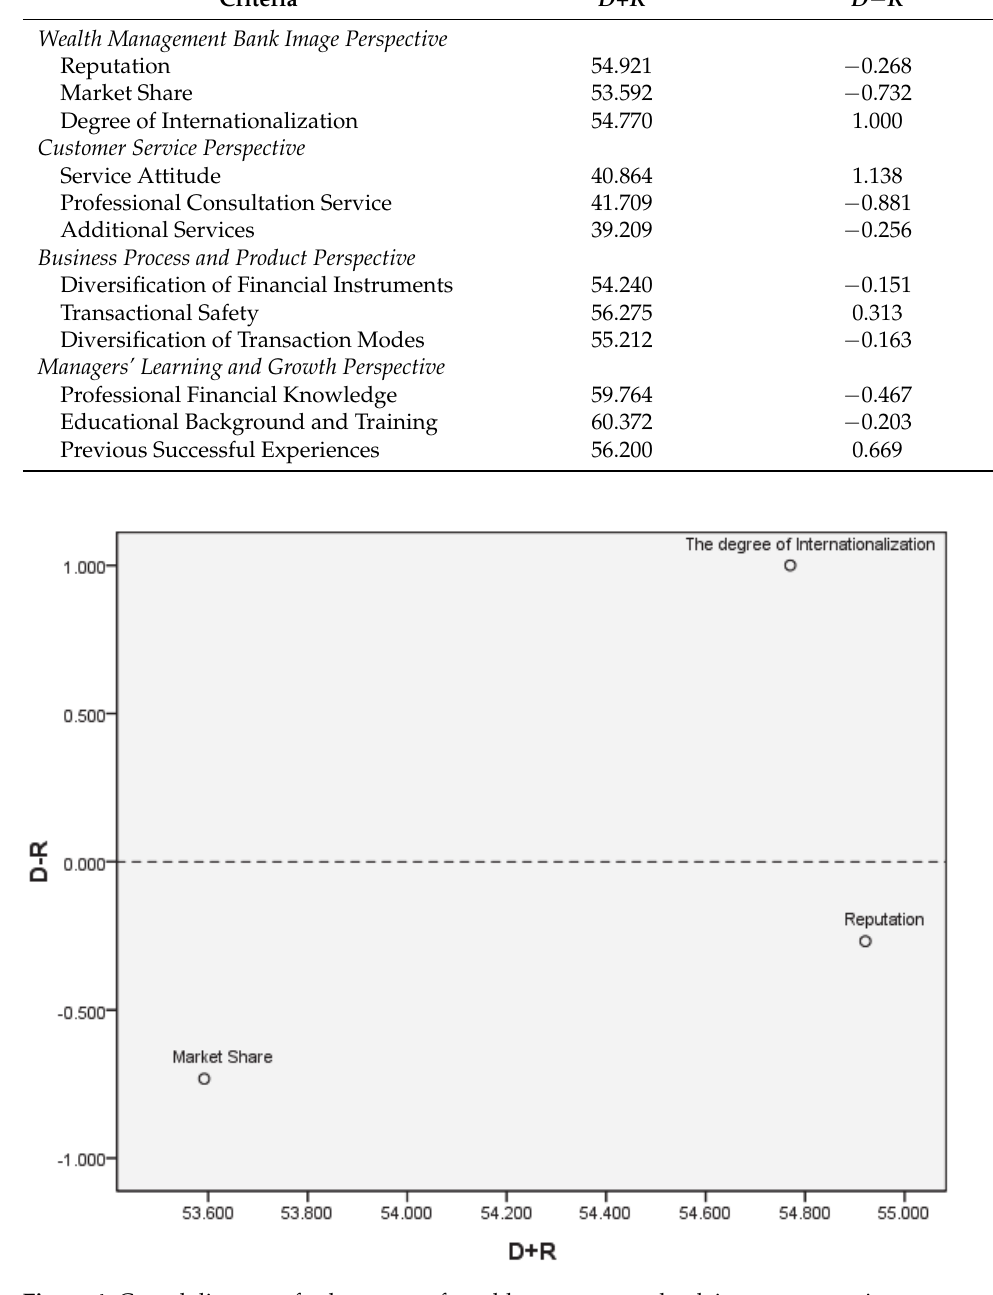
Figure 4. Causal diagram of sub-aspects of wealth management bank image perspective .